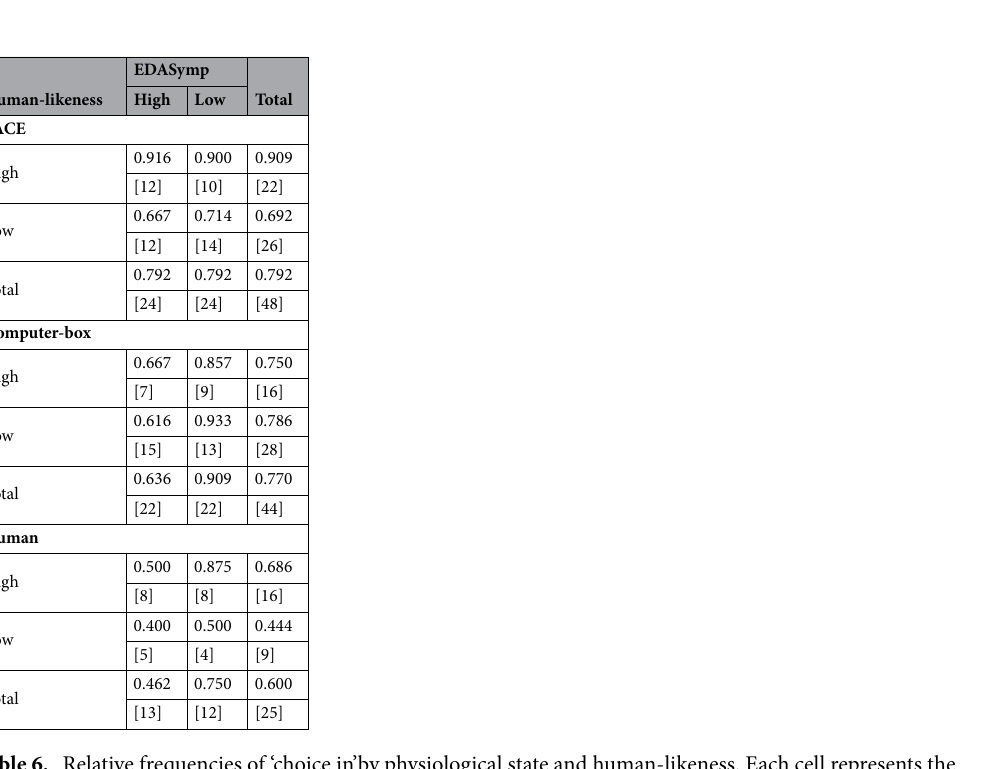
Table 6. Relative frequencies of ‘choice in’by physiological state and human-likeness. Each cell represents the frequencies of choice ‘In’ within each category. An individual is classified in EDAsymp High whenever is above the median level of the EDAsymp distribution, and EDAsymp Low otherwise. Human-likeness is Low when the participant rating is in the lower side of the distribution on the 7-likert scale, and High otherwise. The number of observations are in squared